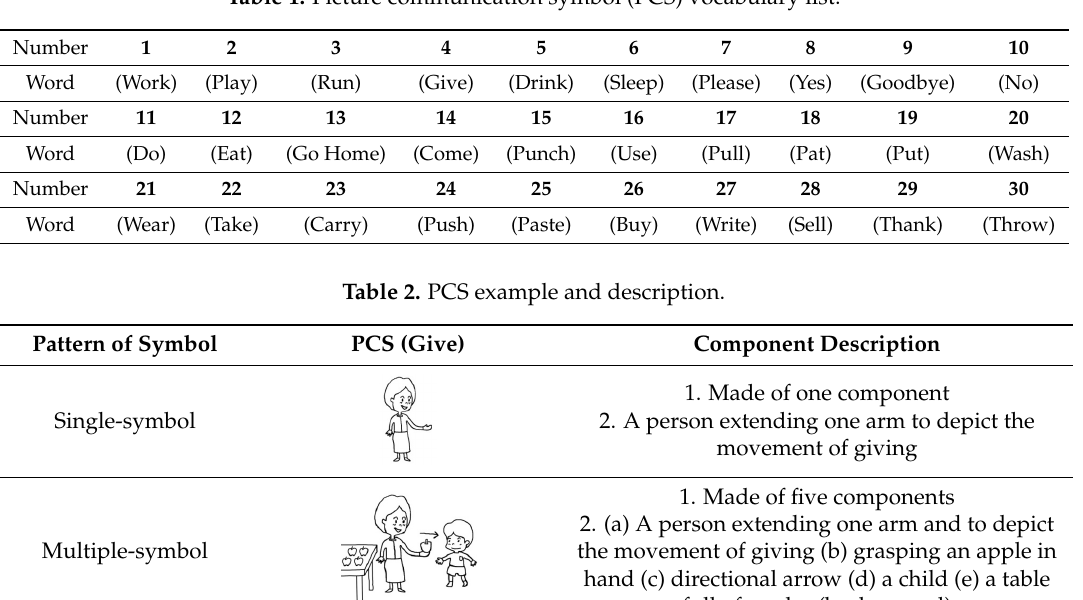
Table 1. Picture communication symbol (PCS) vocabulary list.